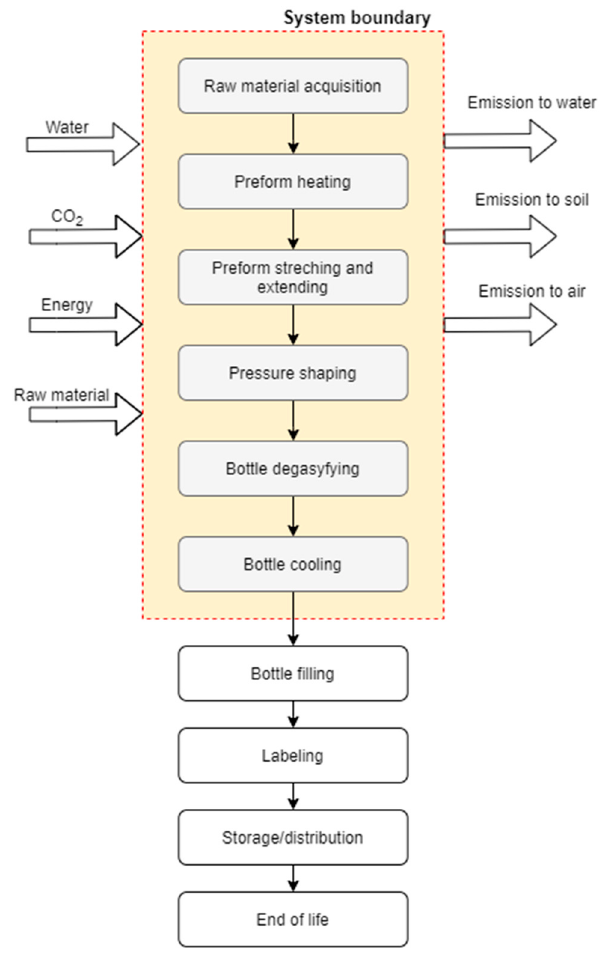
Figure 3. System boundaries for the environmental analysis of the polylactic acid (PLA) bottle production process.